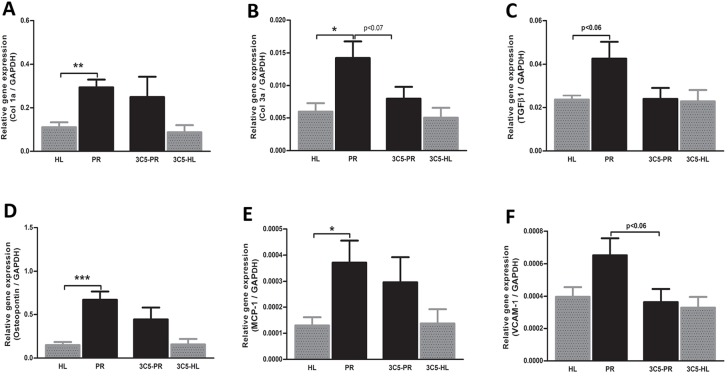
Effects of anti-VEGFR3 antibody treatment on mRNA expression of fibrotic and inflammatory markers. Anti-VEGFR3 injections tended to reduce the proteinuria-induced expression of collagen III (α1) and TGF-β1 mRNA, but not collagen I (α1) (A-C). Likewise, anti VEGFR3 intervention tended to reduce the proteinuria-induced mRNA expression of MCP-1, osteopontin and VCAM-1 (D-F). HL, healthy; PR, proteinuric untreated; 3C5, anti-VEGFR3 antibody. *P<0.05, **P<0.01, ***P<0.001.